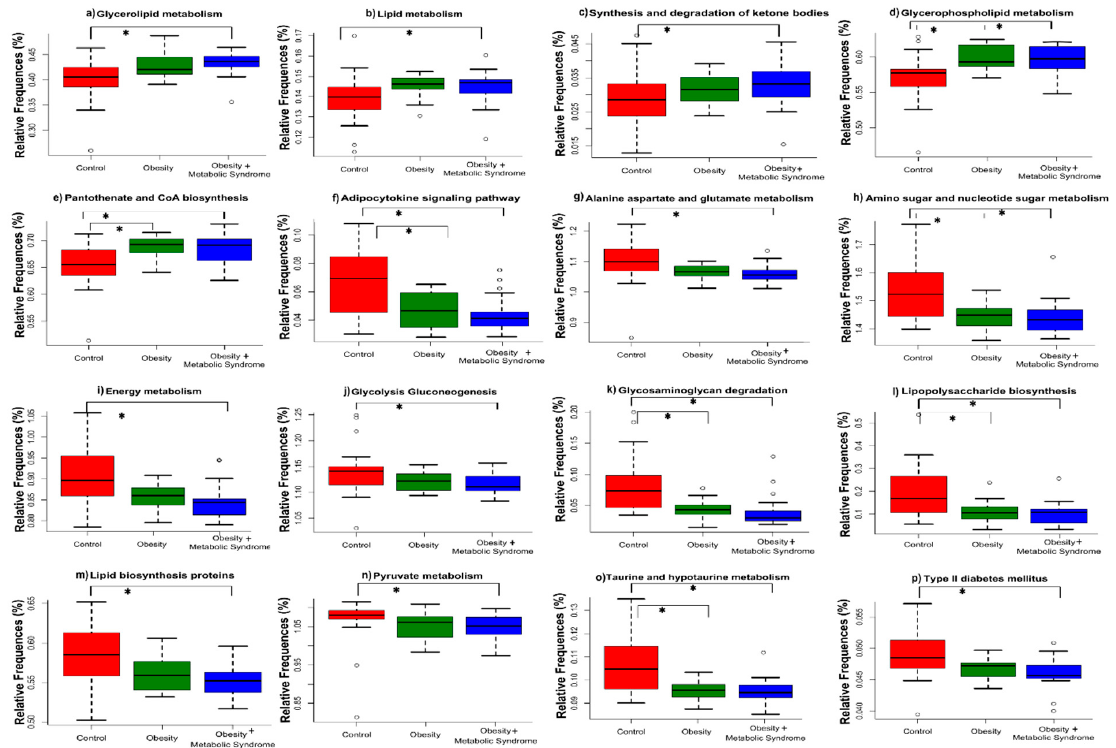
Figure 5. Comparative prediction of the functional metagenome of the gut bacterial microbiota. The figure shows a graphic representation of the significant predicted metabolic pathways using PICRUSt by analysis of the corresponding OTU table generated by QIIME for the bacterial communities. The Y-axis shows the relative frequencies of gene content prediction, and the X-axis shows the control (red), obesity (green) and obesity + metabolic syndrome (blue) categories. *, indicates significant difference among groups (see Table S4).